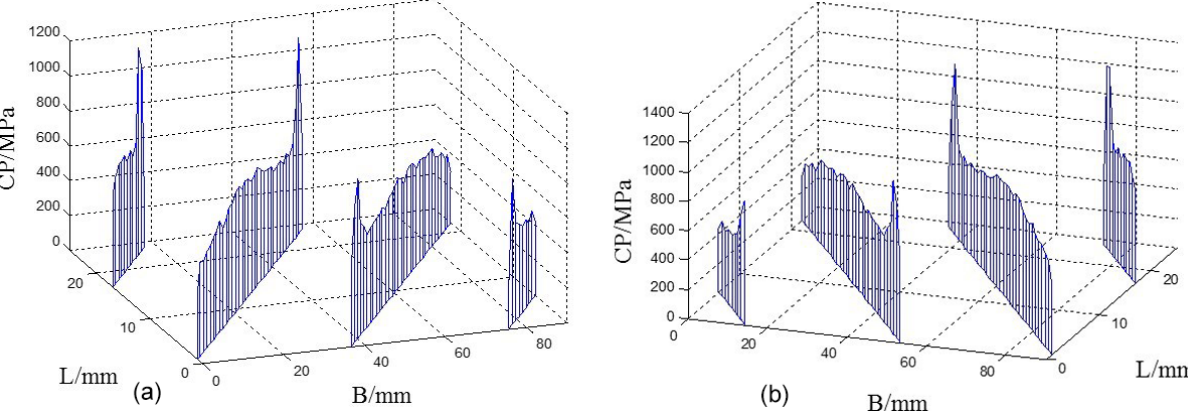
Figure 19. Contact stress distribution of the tooth surface with the stiffness of the no. 4 shaft section. (a) Left tooth surface. (b) Right tooth